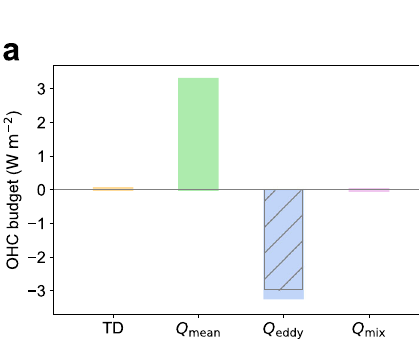
Fig.4|DeepoceanwarmingintheAtlanticOceanduetotheweakenedupward heat transport by mesoscale eddies. a The ocean heat content (OHC) budget in the 800 – 1200m water column over the Atlantic ocean thermal energy conversion (OTEC)region(SupplementaryFig.6b)during1992 – 2021 whereTDrepresentsthe OHCtendency, Q mean theheattransportconvergencebymean fl ows, Q eddy theheat